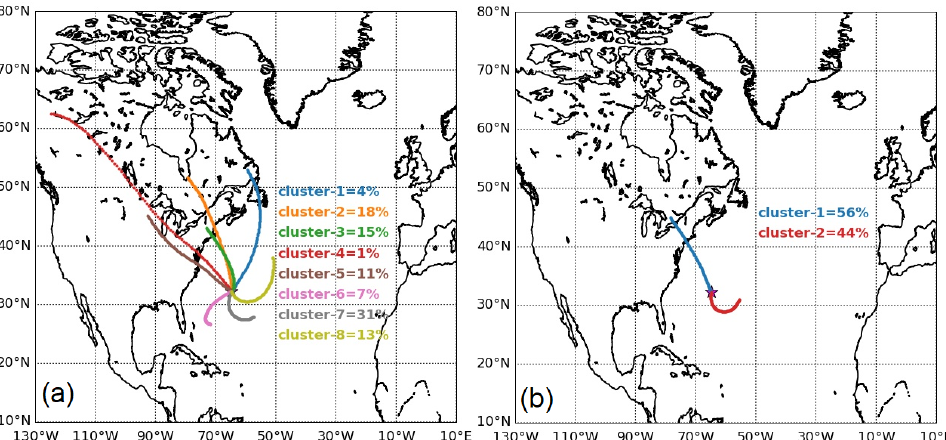
Figure 4. Cluster mean trajectories based on the (a) optimum solution having eight clusters and (b) a simplified solution with two clusters to enhance statistics for North American trajectories. Clustering was performed on 4d HYSPLIT backward trajectories between 1 January 2015 and 31 December